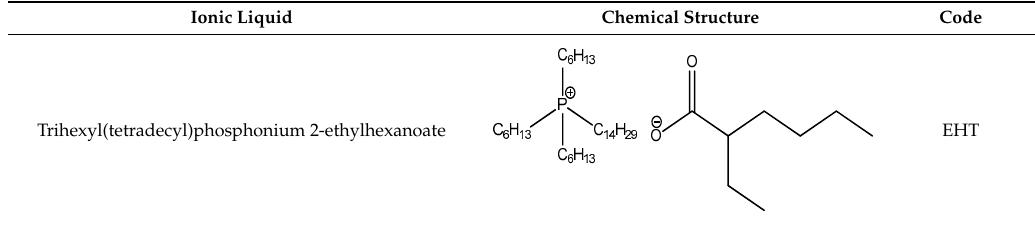
Table 1. Designation of the phosphonium ionic liquid (IL) used for the modification of LDH.